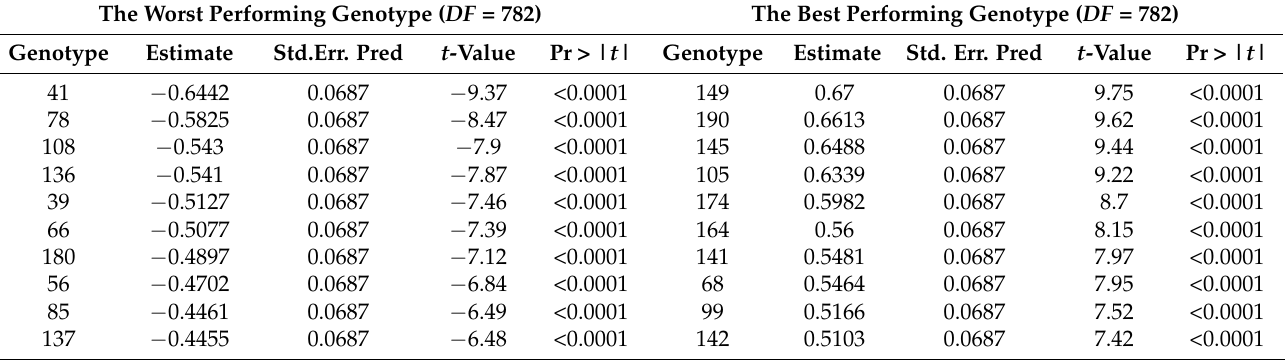
Table 6. The worst and best performing genotypes using BLUP.